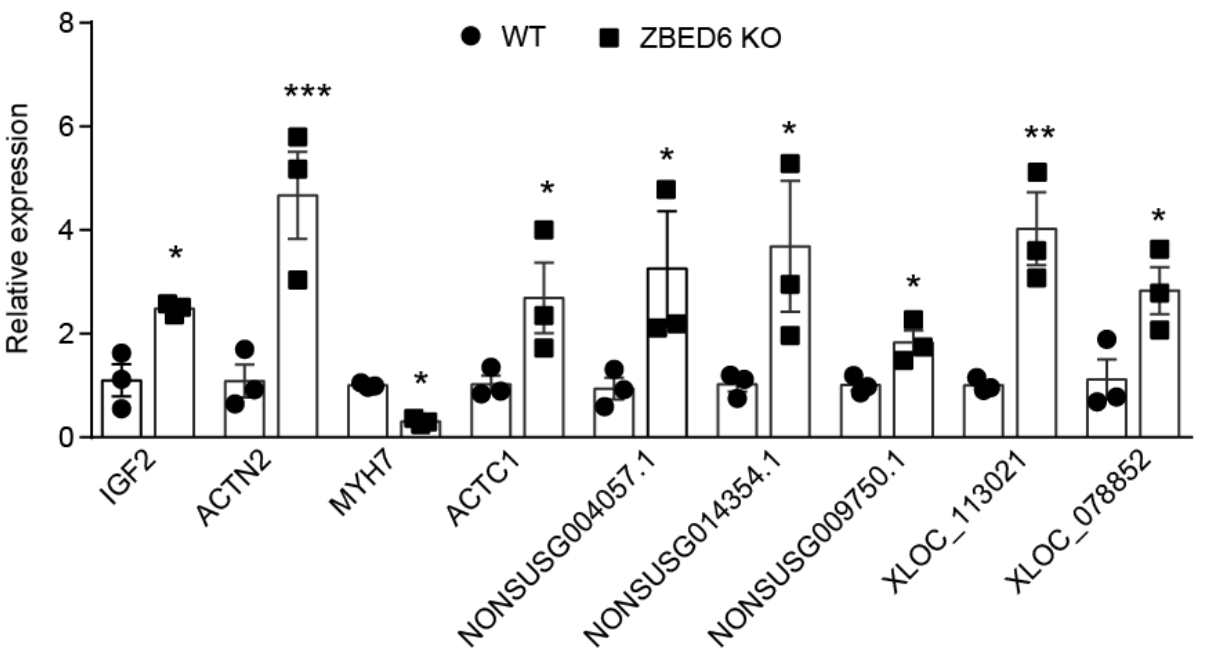
Figure 6. RT-qPCR validation. ***, p < 0.001; **, p < 0.01; *, p < 0.05.